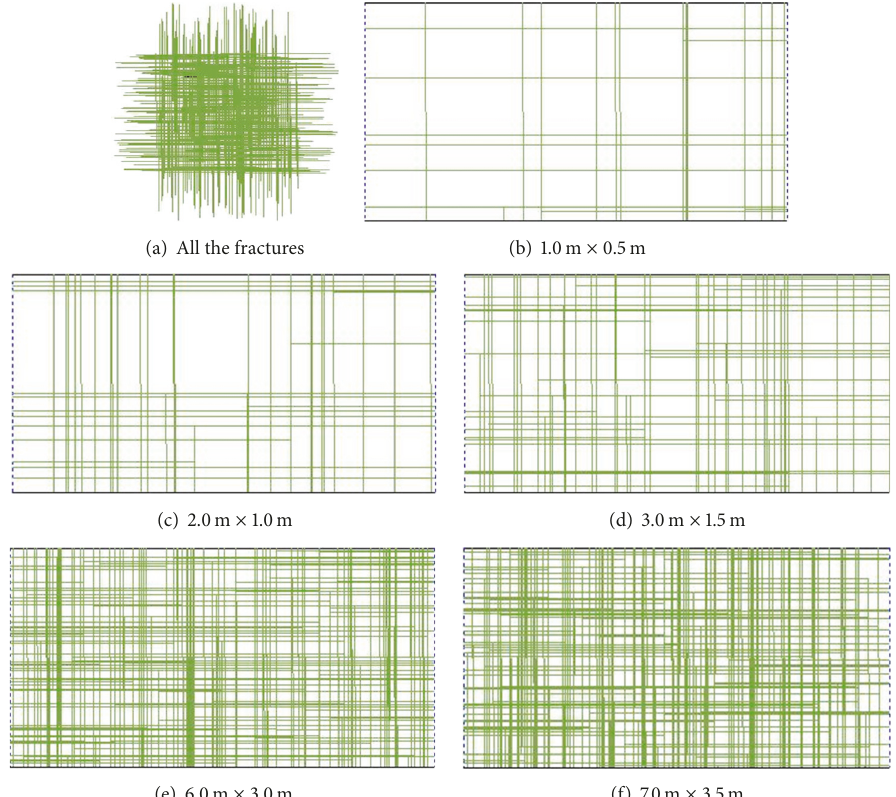
Figure 4: Sketch of fracture of research area.